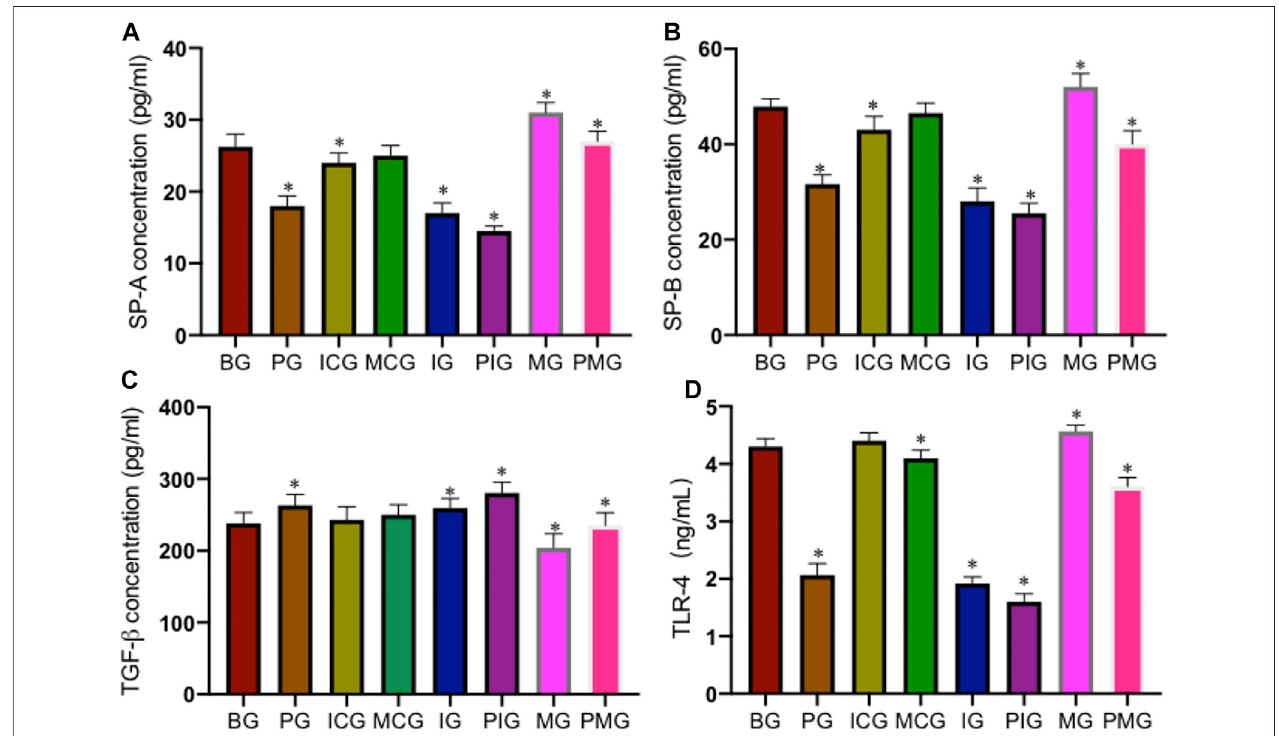
FIGURE4| Thelevelsofserumbiomarkersoflunginjuryamongdifferentgroups. (A) ,SP-Aconcentration. (B) ,SP-Bconcentration. (C) ,TGF- β concentration. (D) , TLR4 concentration. n = 3 for each group. * p < 0.05 vs. the BG group.